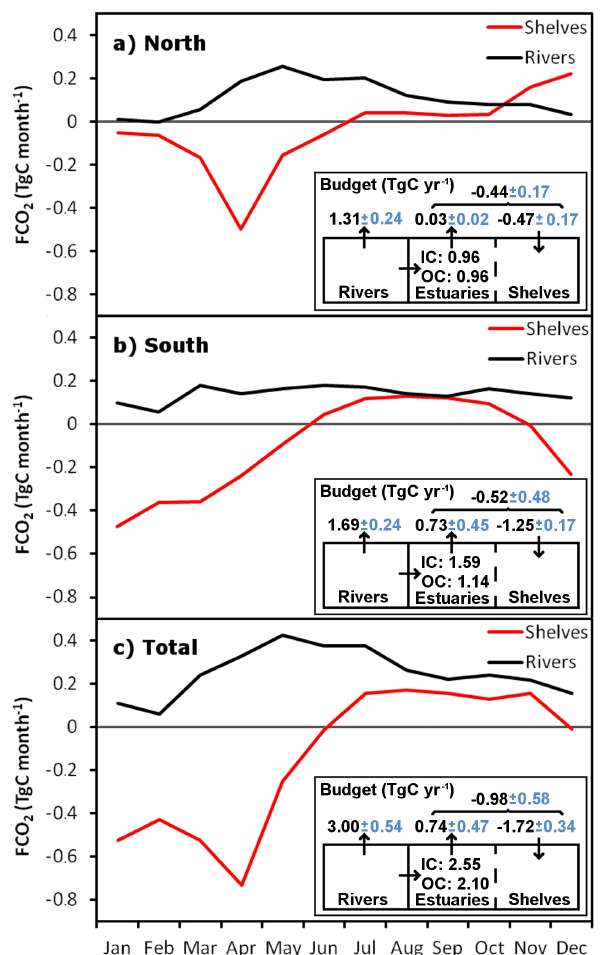
Figure 3. Areal-integrated monthly air–water CO 2 flux for rivers and the continental shelf waters in the North section (a) , South sec- tion (b) , and entire study area (c) . Positive values correspond to fluxes towards the atmosphere. The boxes inside each panel cor- respond to the annual carbon budgets for the region including the lateral carbon fluxes at the river–estuary interface, as inorganic (IC) and organic carbon (OC). The values in grey represent the uncer- tainties of the annual